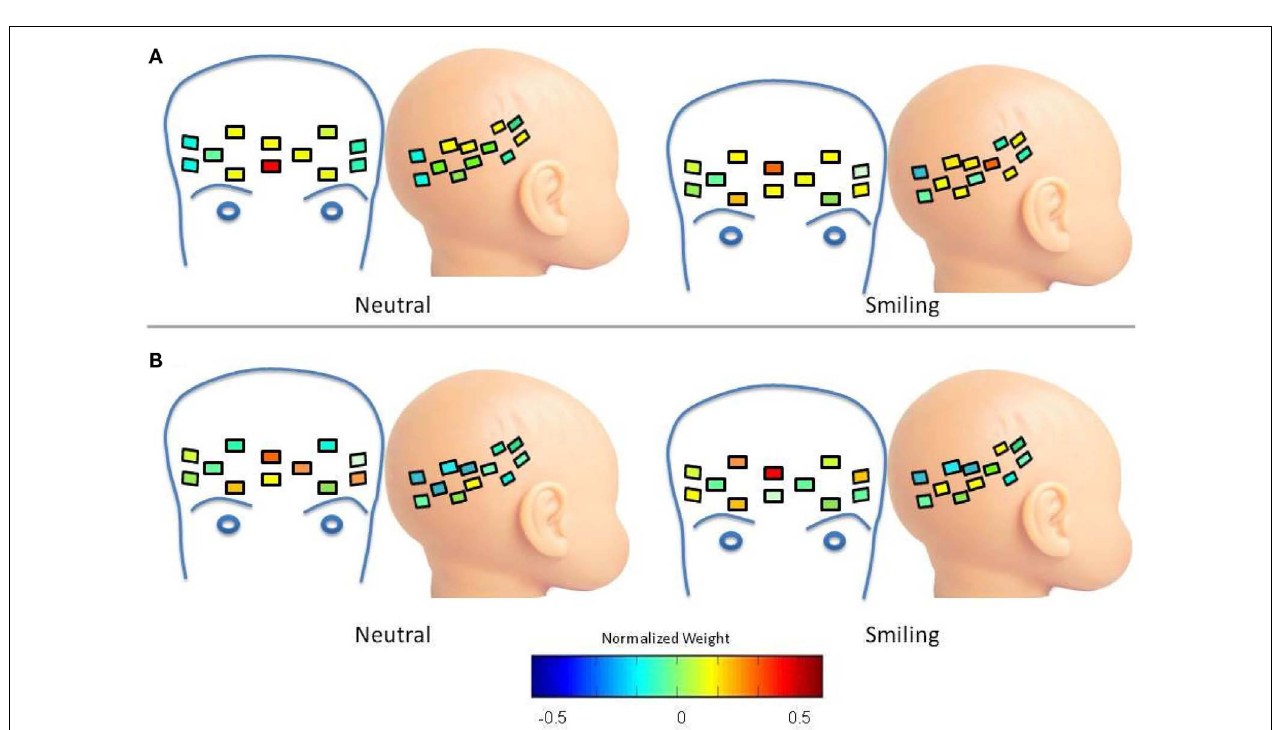
right lateral regions in the smiling condition (B) HRA Group. Frontal weight increases during the smiling condition, resulting in a greater mean weight across frontal channels for the smiling as compared to neutral conditions ( p =